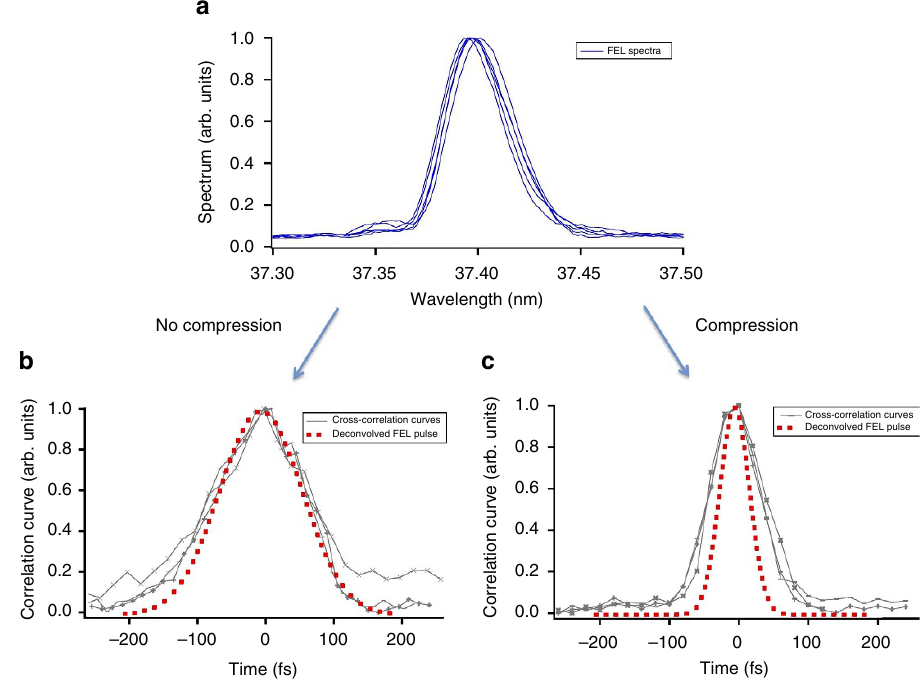
Figure 3 | FEL spectro-temporal characterization. ( a ) Normalized single-shot spectra of the free-electron laser (FEL) pulse generated after stretching the seed pulse. ( b ) Three cross-correlation curves associated to the second sideband (see Fig. 2) for three independent FEL-infrared delay scans. The dotted curves represent the deconvolved FEL pulse (assumed to be Gaussian). ( c ) Same as b for the FEL operated in CPA mode and the grating angles optimized for maximum compression. As can be seen, the correlation curves from independent scans are quite similar to one another. Moreover, the analysis of the cross-correlation curves associated to the third sideband gives similar results (see Fig. 4). This strongly supports the reliability of the reported results.